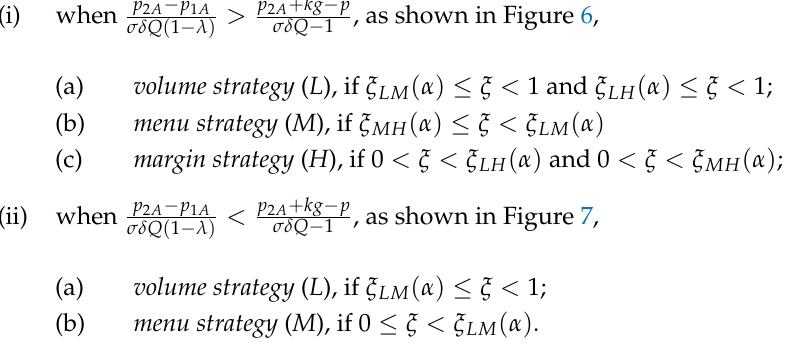
Figure 7. Comparison of the four strategies given (cid:2012) (cid:3404) 3 when (cid:3043) (cid:3118)(cid:3250) (cid:2879)(cid:3043) (cid:3117)(cid:3250) (cid:3097)(cid:3083)(cid:3018)(cid:4666)(cid:2869)(cid:2879)(cid:3090)(cid:4667) (cid:3407) (cid:3043) (cid:3118)(cid:3250) (cid:3397)(cid:1863)(cid:1859) (cid:2879)(cid:3043) (cid:3097)(cid:3083)(cid:3018)(cid:2879)(cid:2869) . In Figure 6, we find that only when the fraction of the high ‐ type consumers is small and the gap between the high and low valuations is large, is the menu strategy ( M ) applicable. In this case, the creator should choose to produce two products of differential quality levels and make two differential prices to satisfy consumer needs. When both the fraction of high ‐ type consumers and the gap between the high and low valuations are high, the margin strategy ( H ) is the most applicable. In Figure 7, the menu strategy ( M ) occupies a large application region with a large α and (cid:2869) (cid:3093) . In this case, the creator should choose to produce two products of differential quality levels to satisfy the needs of consumers with different valuations. Likewise, when both the fraction of the high ‐ type consumers and the gap between the high and low valuations is small, the volume strategy ( L ) begins to show its applicability. 5. Exploring the Influence of the Fraction of Strategic Consumers ( (cid:2242) ) on the Total Profits We take the case of (cid:1874) (cid:2870)(cid:3002) (cid:3407) (cid:1874) (cid:2869)(cid:3003) and (cid:3043) (cid:3118)(cid:3250) (cid:2879)(cid:3043) (cid:3117)(cid:3250) (cid:3097)(cid:3083)(cid:3018)(cid:4666)(cid:2869)(cid:2879)(cid:3090)(cid:4667) (cid:3409) (cid:3043) (cid:3117)(cid:3250) (cid:2879)(cid:3043) (cid:3090)(cid:3097)(cid:3083)(cid:3018)(cid:2879)(cid:2869) as an example to explore the influence of the fraction of strategic consumers ( (cid:2016) ) on the total profits of the creator, as shown in Figure 8. (cid:1842)(cid:4666)(cid:2009) (cid:2869) , (cid:2022) (cid:2869) (cid:4667) is a point in Figure 1. We next explore the behavior of (cid:1842)(cid:4666)(cid:2009) (cid:2869) , (cid:2022) (cid:2869) (cid:4667) by changing the fraction of strategic consumers ( (cid:2016) ).